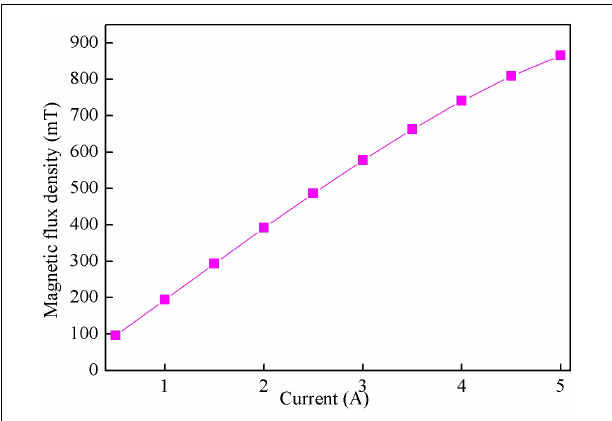
FIGURE 5 | The flow curve of MRG-70 under various magnetic flux density. model is defined as (Rabbani et al., 2015):